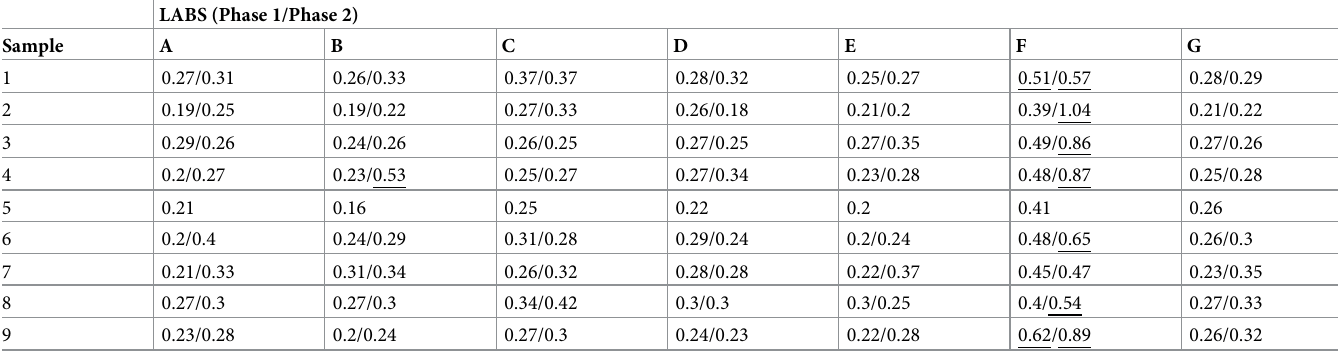
Table 15. Median of the absolute values of pairwise differences across labs.